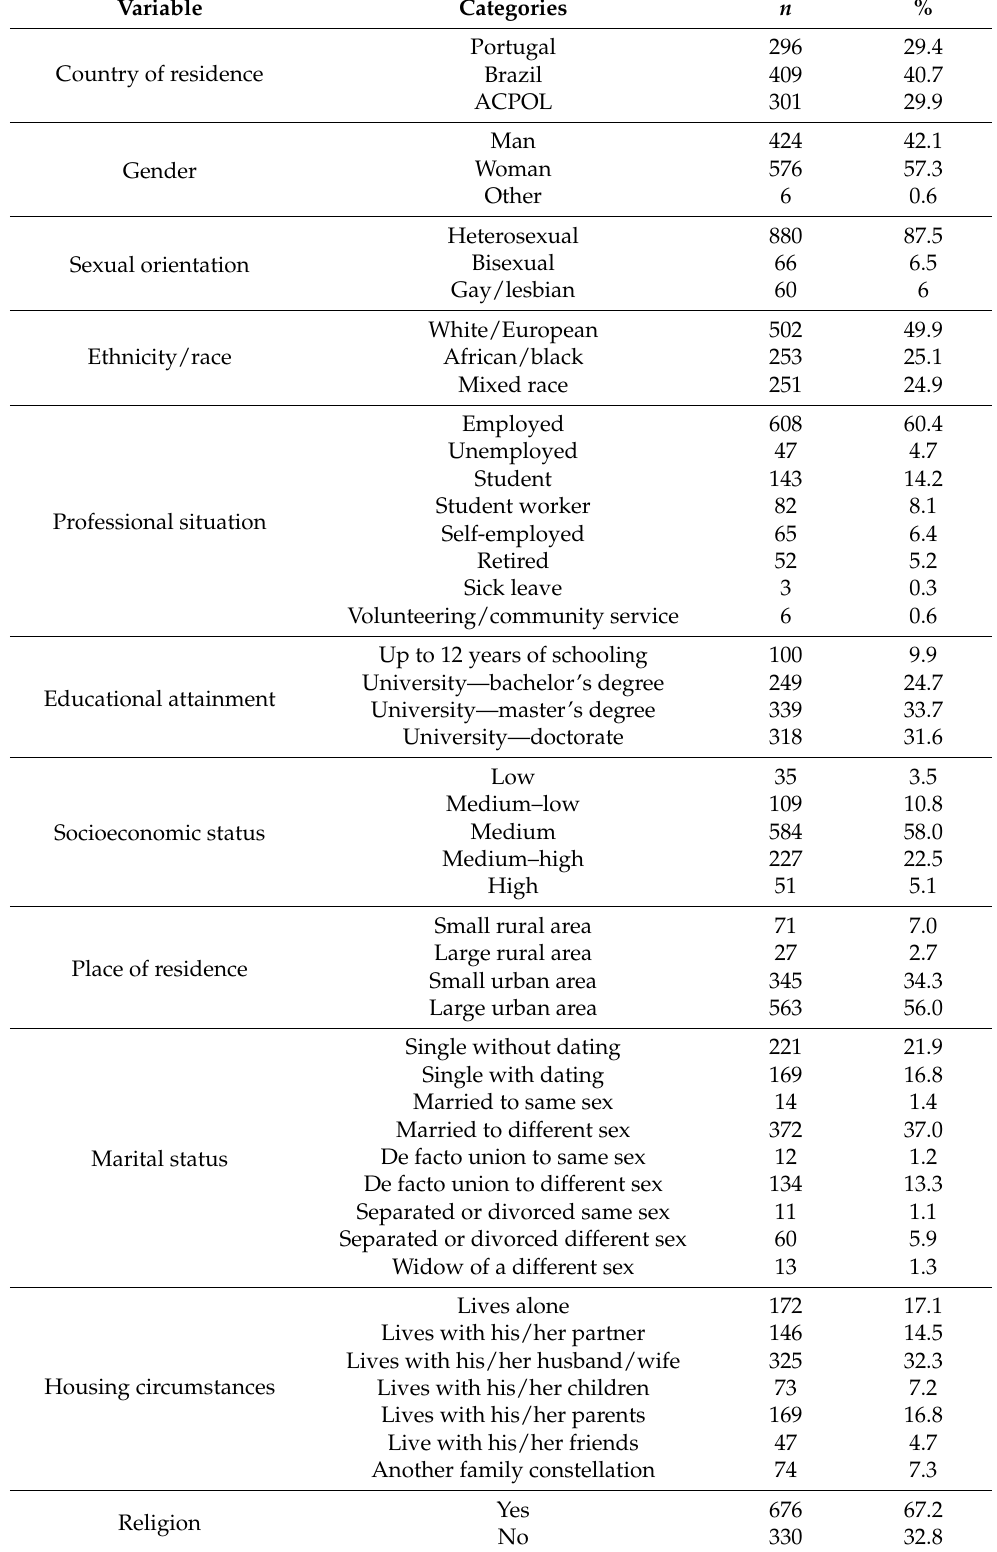
Table 1. Sociodemographic characteristics (Mean = 41.76; SD = 14.185).